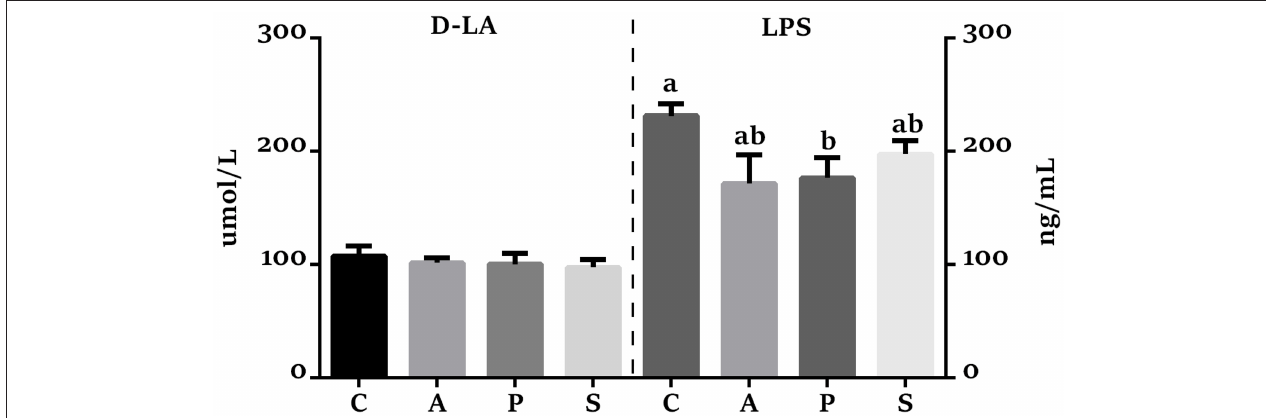
FIGURE 4 | Effects of maternal probiotic and synbiotic supplementation on the plasma concentrations of D-lactate (D-LA) and Lipopolysaccharide (LPS) of offspring piglets. Data are represented as means ± SEM, n = 8 per group. Different letters indicate significant differences among the groups ( P < 0.05). C, control group; A, antibiotic group; P, probiotic group; and S, synbiotic